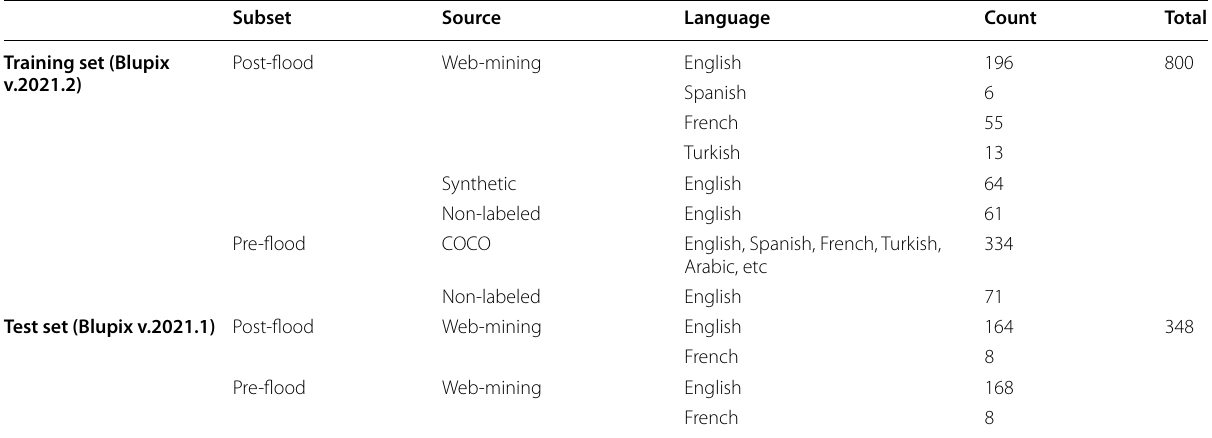
Test set (Blupix v.2021.1)